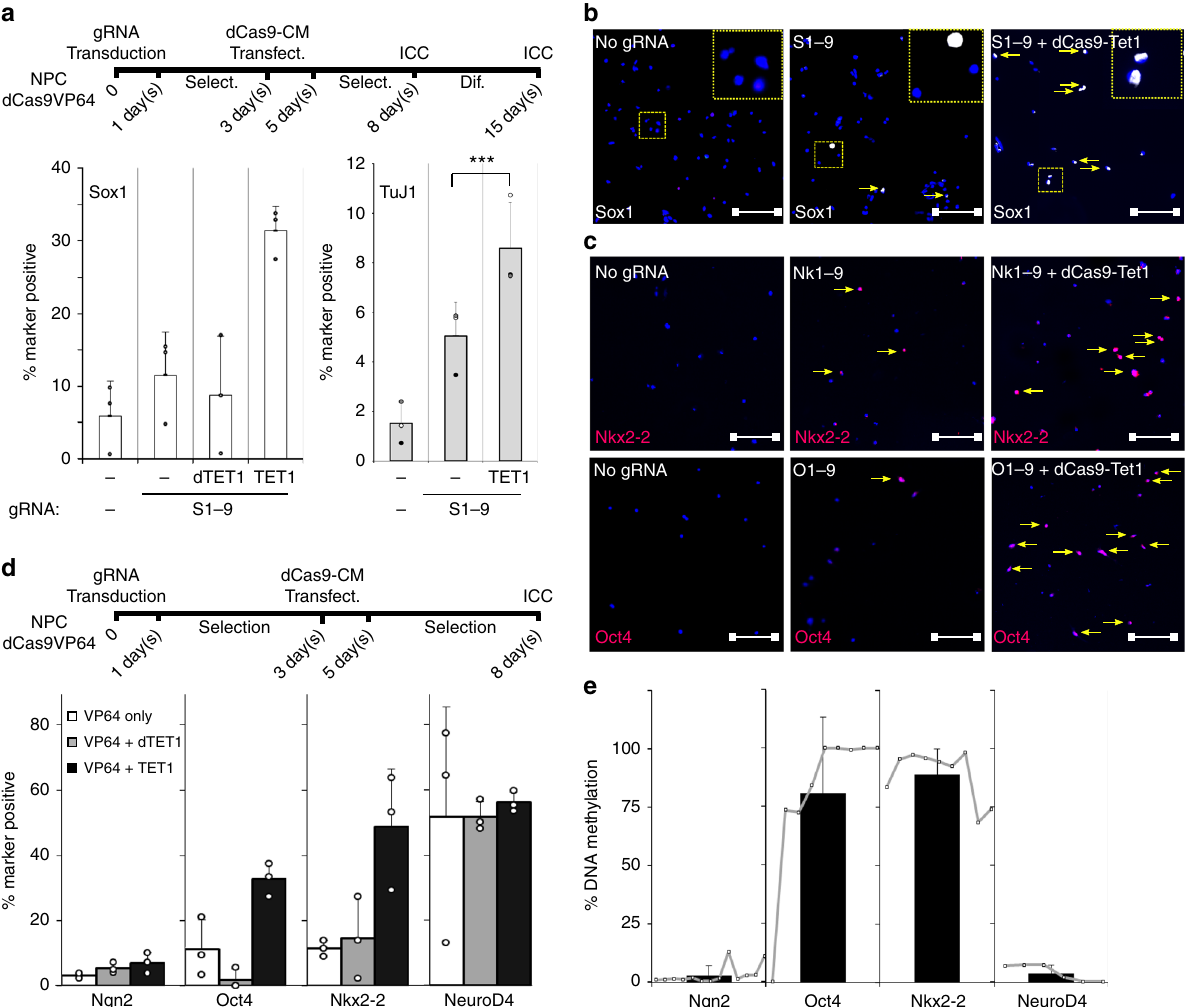
Fig. 6 DNA methylation as a barrier to transcriptional engineering is not an exclusive feature of Sox1 . a , b Combination of transcriptional engineering with epigenome editing increases the neuronal differentiation potency of NPCs. NPCs stably expressing dCas9-VP64 were transduced with Sox1 -targeting gRNAs (S1-9) and subsequently transfected with dCas9-Tet1 or dCas9-dTet1. NPCs were stained for Sox1 or differentiated for 7 more days, respectively. Sox1 staining revealed a higher number of Sox1-positive cells when dCas9-VP64 is combined with dCas9-Tet1 but not with dCas9-dTet1. After differentiation, more cells differentiated into the neuronal lineage, as indicated by the higher Tuj1 positivity after epigenome editing compared to transcriptional editing alone. Data are shown as the mean and standard error of the mean of n = 3 biological replicates, performed on different days in different clonal lines. *** p < 0.005 calculated by two-sided Student ’ s t-test. Dashed yellow lines mark magni fi ed areas; scale bar: 100 µ m. c , d Activation of different master transcription factors reveals varying responsiveness to transcriptional engineering and sensitivity to DNA demethylation. NPCs